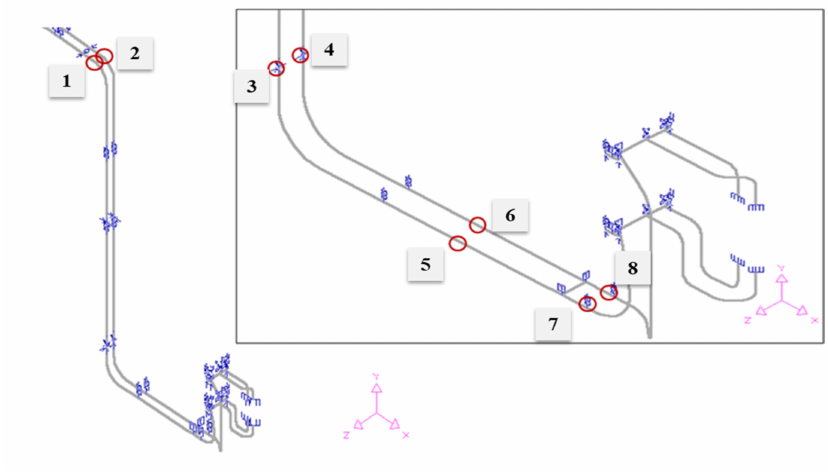
Figure 1. Modeling and 3D displacement measurement positions in the main steam pipe using CAESARII.